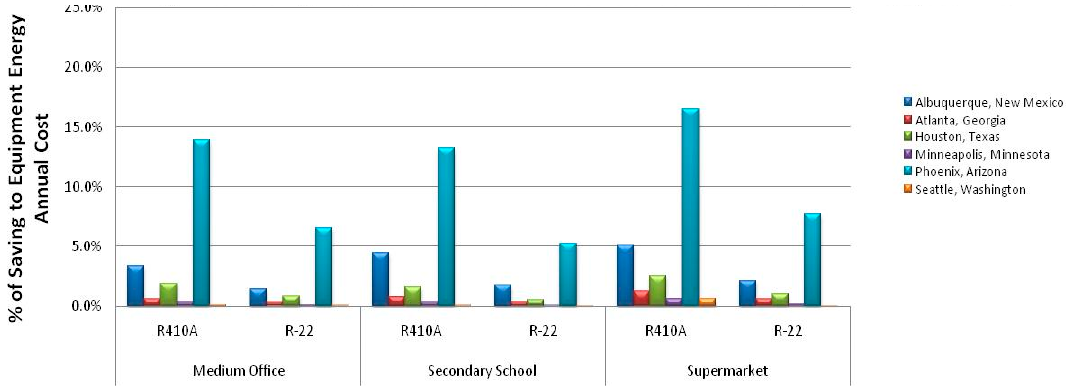
Figure 12. Percentage of energy savings due to pre-cooling relative to no pre-cooling when water is sprayed after ambient temperature is equal to or exceeds 90°F. Wet bulb efficiency = 0.9, equipment COP = 3.